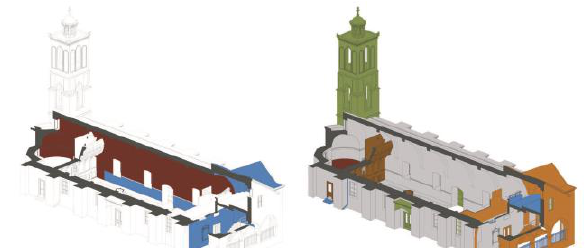
Figure 19. Diachronic analysis with filters and visualization